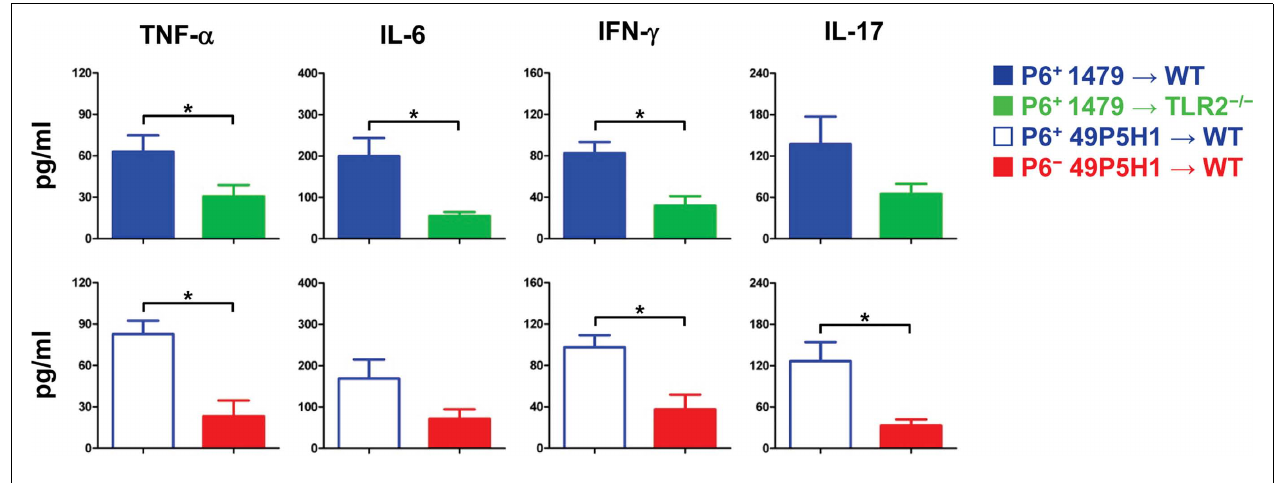
(cid:2)(cid:2) , P6 + 49P5H1 ( (cid:3) ), or P6 − 49P5H1 ( (cid:2) ) NTHI were analyzed by sandwich ELISA. * p < 0.01, one-way ANOVA. Average ±